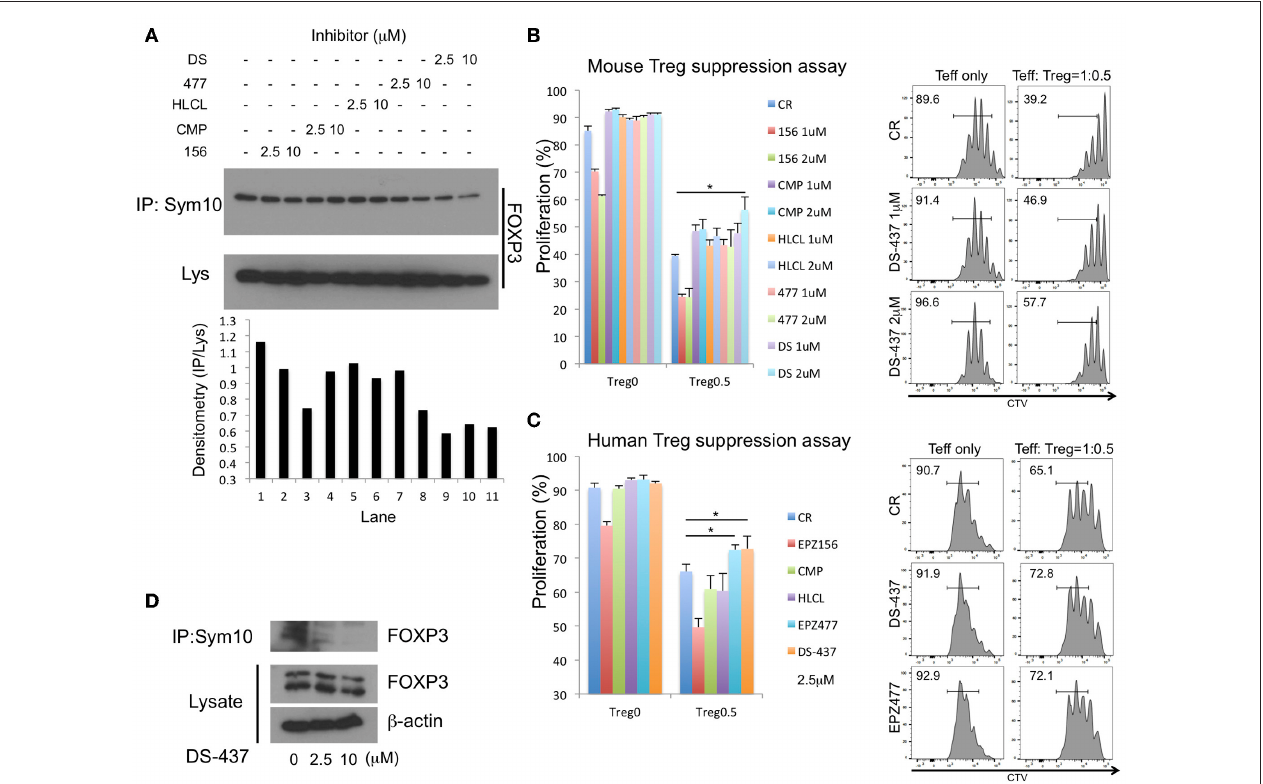
FIGURE 6 | Effect of PRMT5 inhibitors on FOXP3 methylation and Treg function. (A) effect of PRMT5 inhibitors on FOXP3 methylation in 293T cells. 293T cells were transfected with FOXP3. After 24h of transfection, the cells were incubated with indicated inhibitors for 16h, then subjected to symmetrical dimethylation analysis as described above. 156: EPZ015666. CMP: CMP5. HLCL: HLCL61. 477: EPZ004777. DS: DS-437. (B,C) effect on suppressive function of mouse (B) and human (C) Treg suppression assay. The error bars indicate the SD value. * P < 0.05 with control vehicle groups calculated by one way ANOVA with Tukey HSD test. (D) effect of PRMT5 inhibitor DS-437 on FOXP3 methylation in expanded human